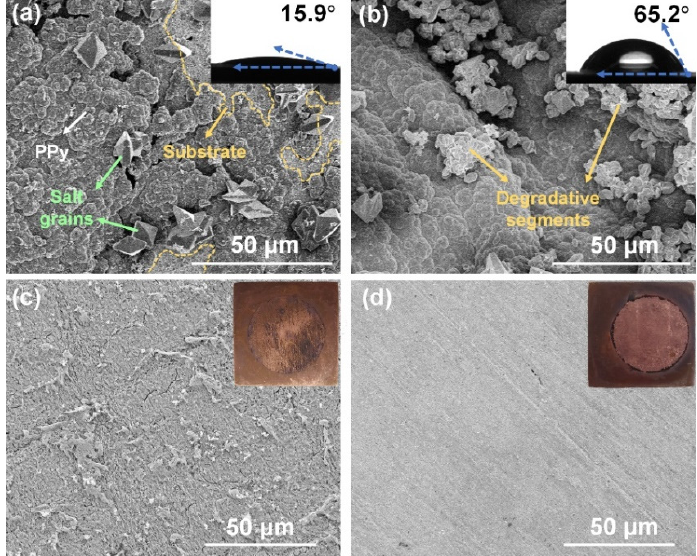
Figure 6. SEM images for PPy-T ( a ) inset: wettability and PPy-I ( b ) inset: wettability coated copper after 24 h immersion in ASW at 358 K along with the corresponding microscopic and macroscopic (inset) morphologies of substrates after mechanically delaminating PPy-T ( c ) and PPy-I ( d ).